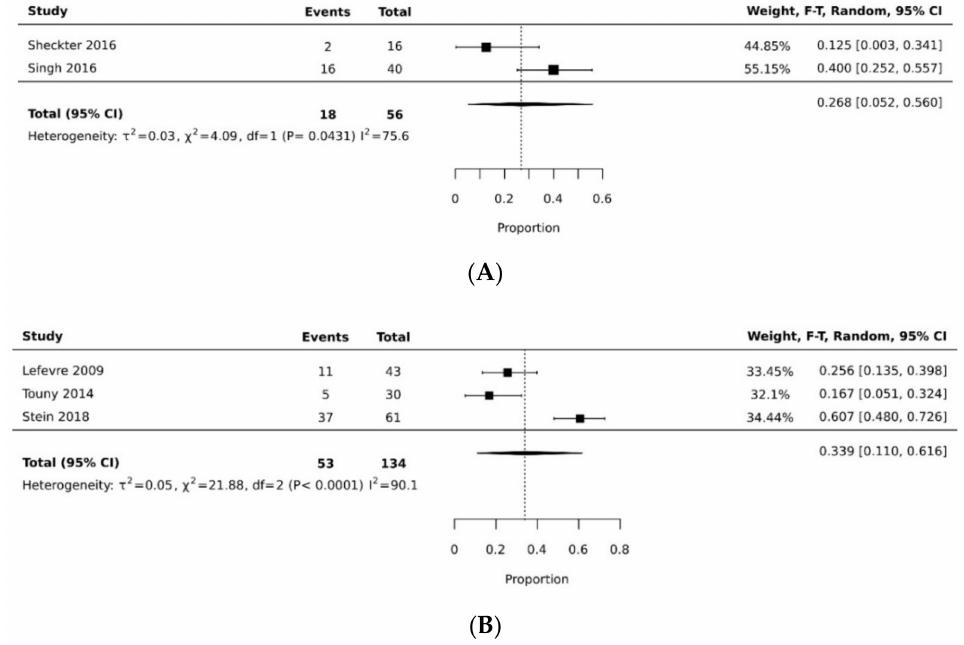
Figure 3. ( A ) Forest plot of gracilis overall recipient site complication rate [21,37]. ( B ) Forest plot of VRAM overall recipient site complication rate